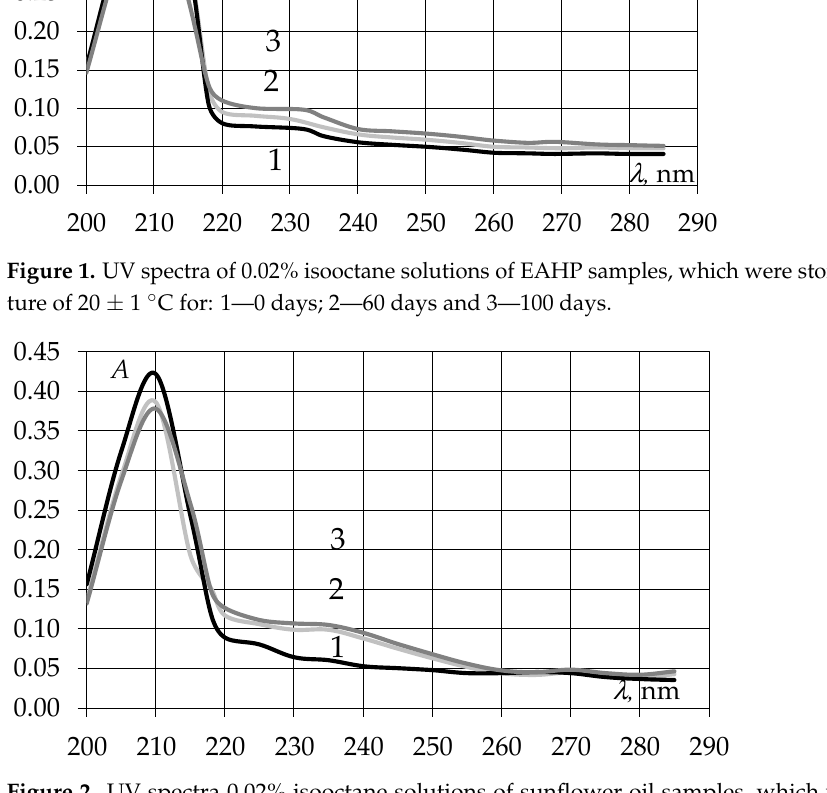
Figure 2. UV spectra 0.02% isooctane solutions of sunflower oil samples, which were stored at a temperature of 20 ± 1 °C for: 1—0 days; 2—60 days and 3—100 days.